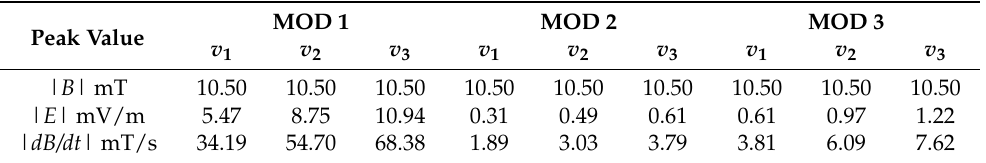
Table 3. Peak values of the calculated exposure parameters for z = 80 cm (hip in standing position or head in squatting position).